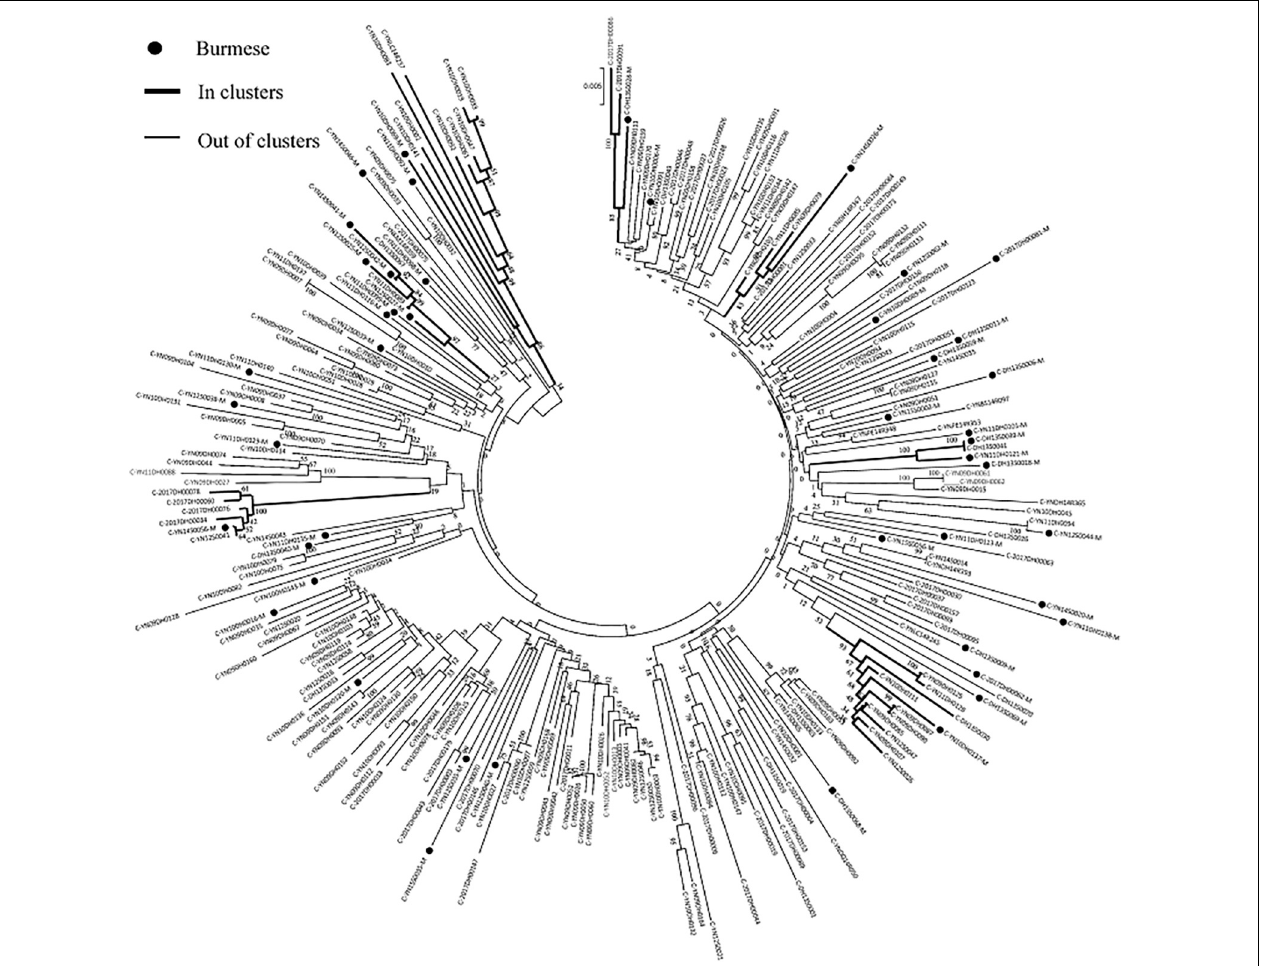
FIGURE 3 | Clustering of HIV-1 sequences within the biggest molecular transmission clusters for subtypes C. The tree was constructed using MEGA 7.0 with 1,000 bootstrap replicates. Molecular transmission clusters (MTC) were defined as clusters with two or more sequences and the pairwise gene distance less than or equal to 0.03 with bootstrap values ≥ 80%. The scale bar indicates 0.5% nucleotide sequence divergence. The black nodes represent Burmese. The thick line indicates individuals in clusters. The thin line indicates individuals out of